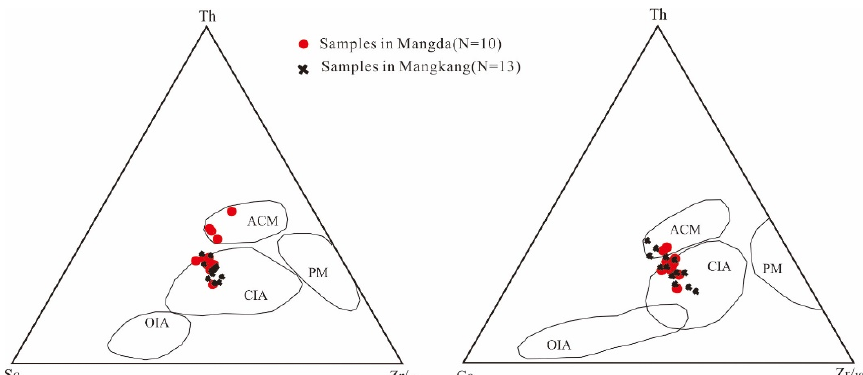
Figure 11. Tectonic setting discrimination diagrams based on the trace elements of Jingxing Formation sandstones from the Qamdo district. Abbreviations: OIA, ocean island arc; CIA, continental island arc; ACM, active continental margin; PM, passive margin (after Bhatia et al.; 1986 [27]).